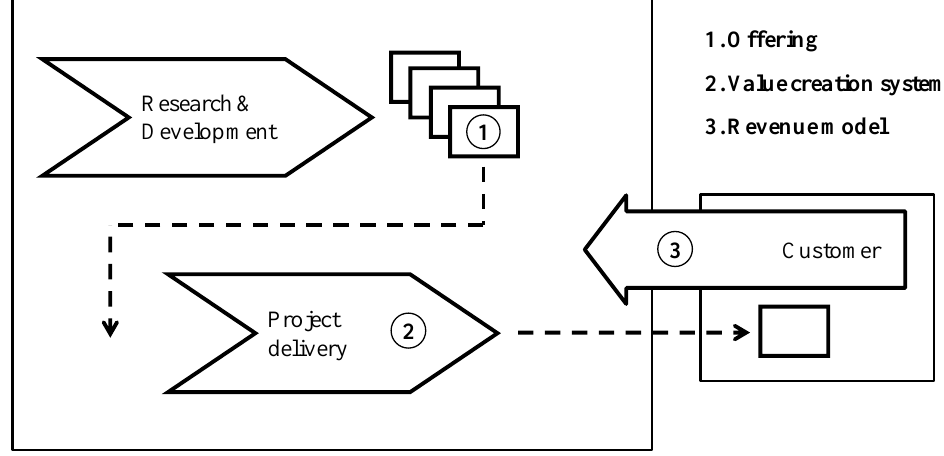
Figure 1 Interdependent business model elements in a process